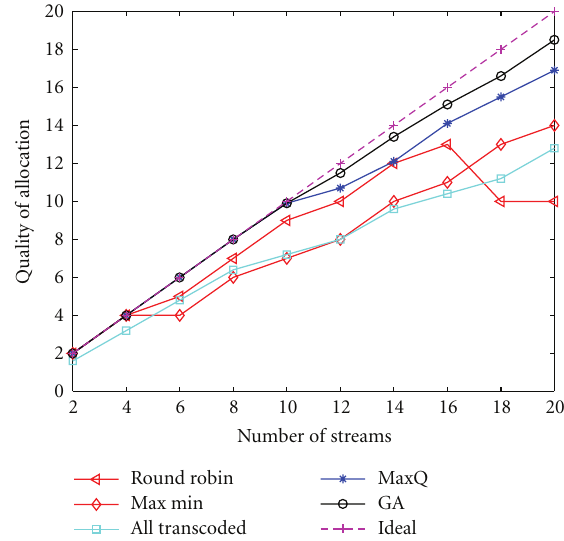
Figure 5: Performance of strategies versus system load.